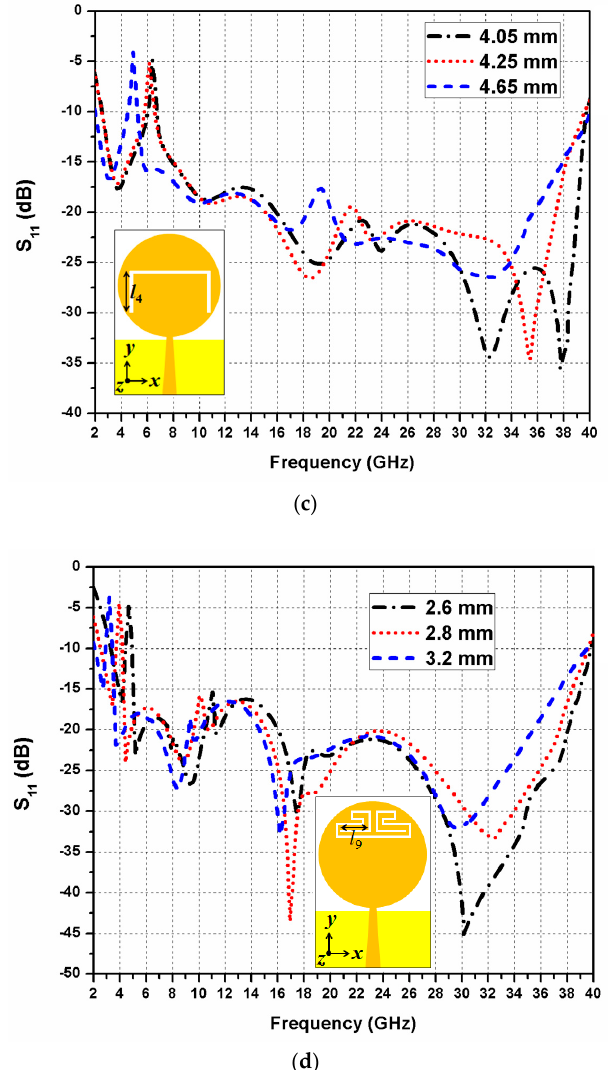
Figure 7. Simulated reflection coefficients of the antenna: ( a ) when b 1 is varied, ( b ) when l 3 is varied, ( c ) when l 4 is varied, ( d ) when l 9 is varied.